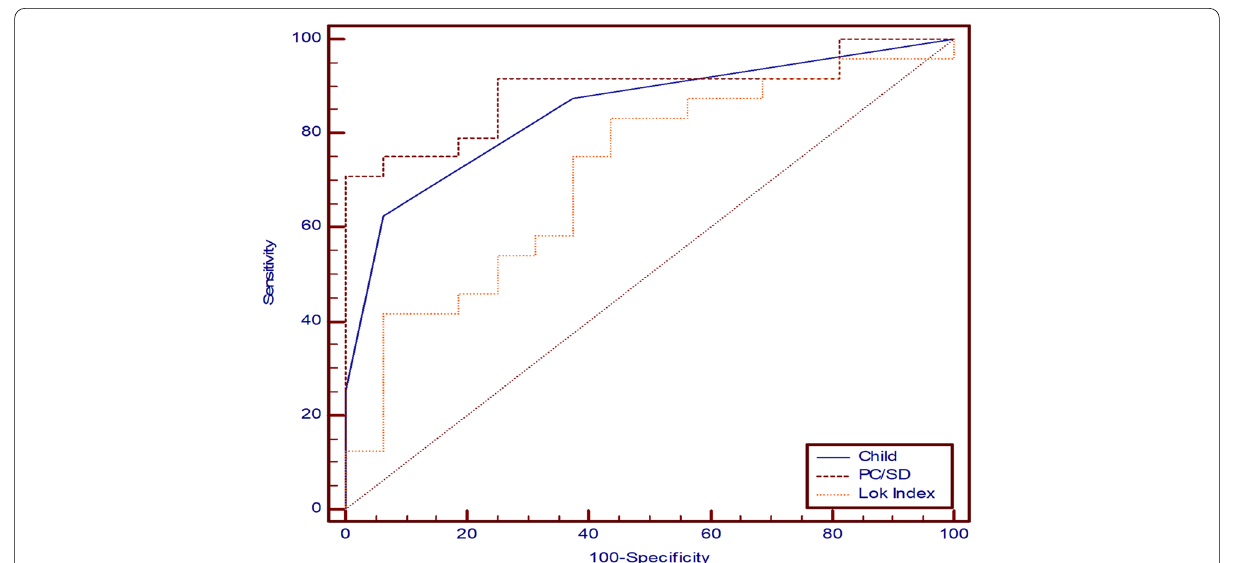
Fig. 2 Prediction of portal hypertension reversibility in patients with HCV‑related liver cirrhosis with